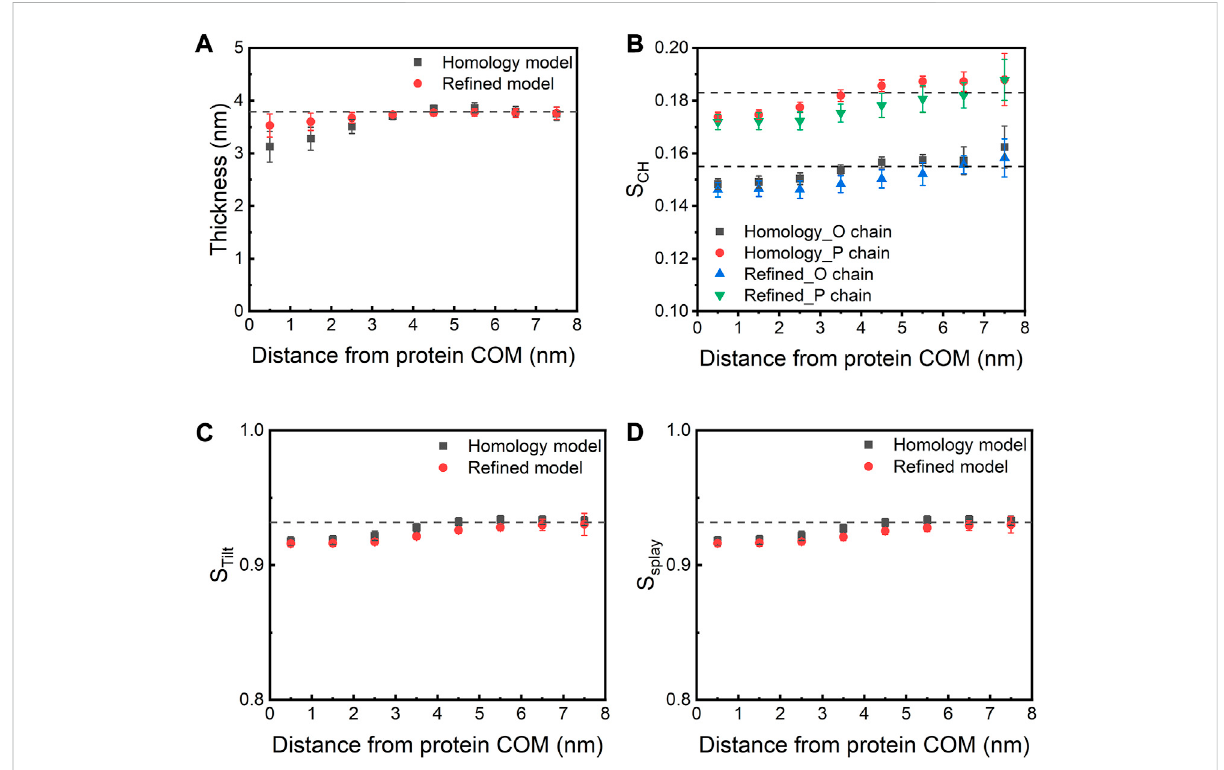
FIGURE 6 (A) Membrane thickness and (B) order parameter as a function of the distance from the COM of the E protein. The dashed lines indicate the corresponding values calculated from theAA-MD simulation (200 ns)of apure POPC bilayer. (C) S Tilt and (D) S Splay as afunction ofthedistancefrom the COM of the E protein. S Tilt is calculated as the average tilt angle of a lipid with respect to the bilayer normal. S Splay re fl ects the divergence of local lipids